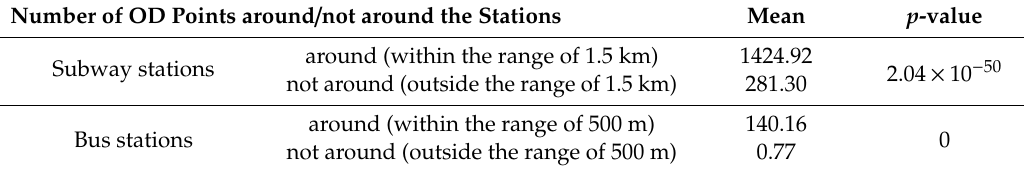
Table 1. Two-sample t -test.